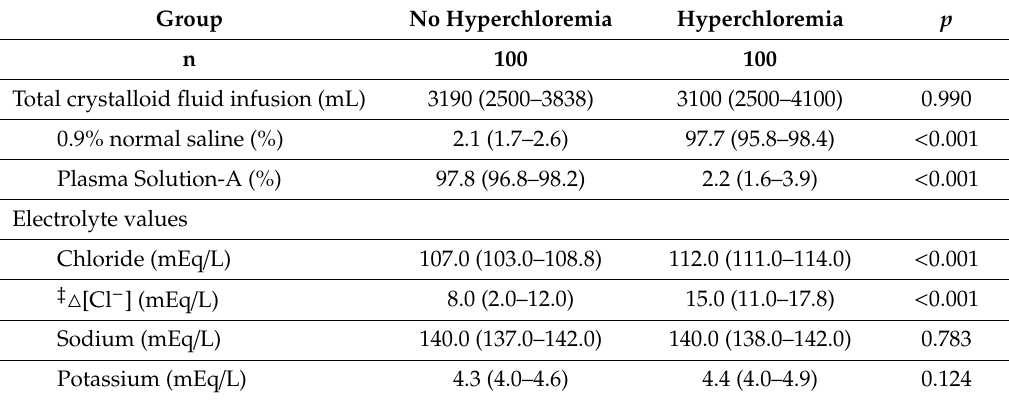
Table 3. Comparison of main crystalloid fluid during surgery and electrolyte values immediately after surgery between propensity score-matched non-hyperchloremia and hyperchloremia groups.